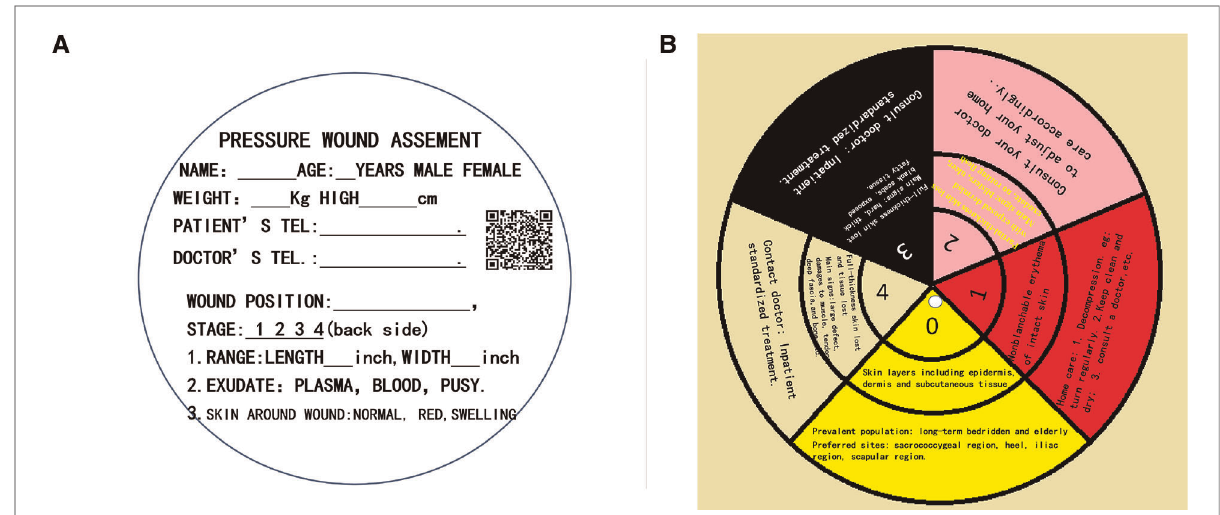
FIGURE 1 ( A ) The front of the big card: patients ’ general information, wound evaluation, and WeChat QR code on the front side. ( B ) The back of the big card: a different color correlates to a different pressure ulcer stage. There are three circles that represent stage, skin injury, and relevant treatment, respectively.